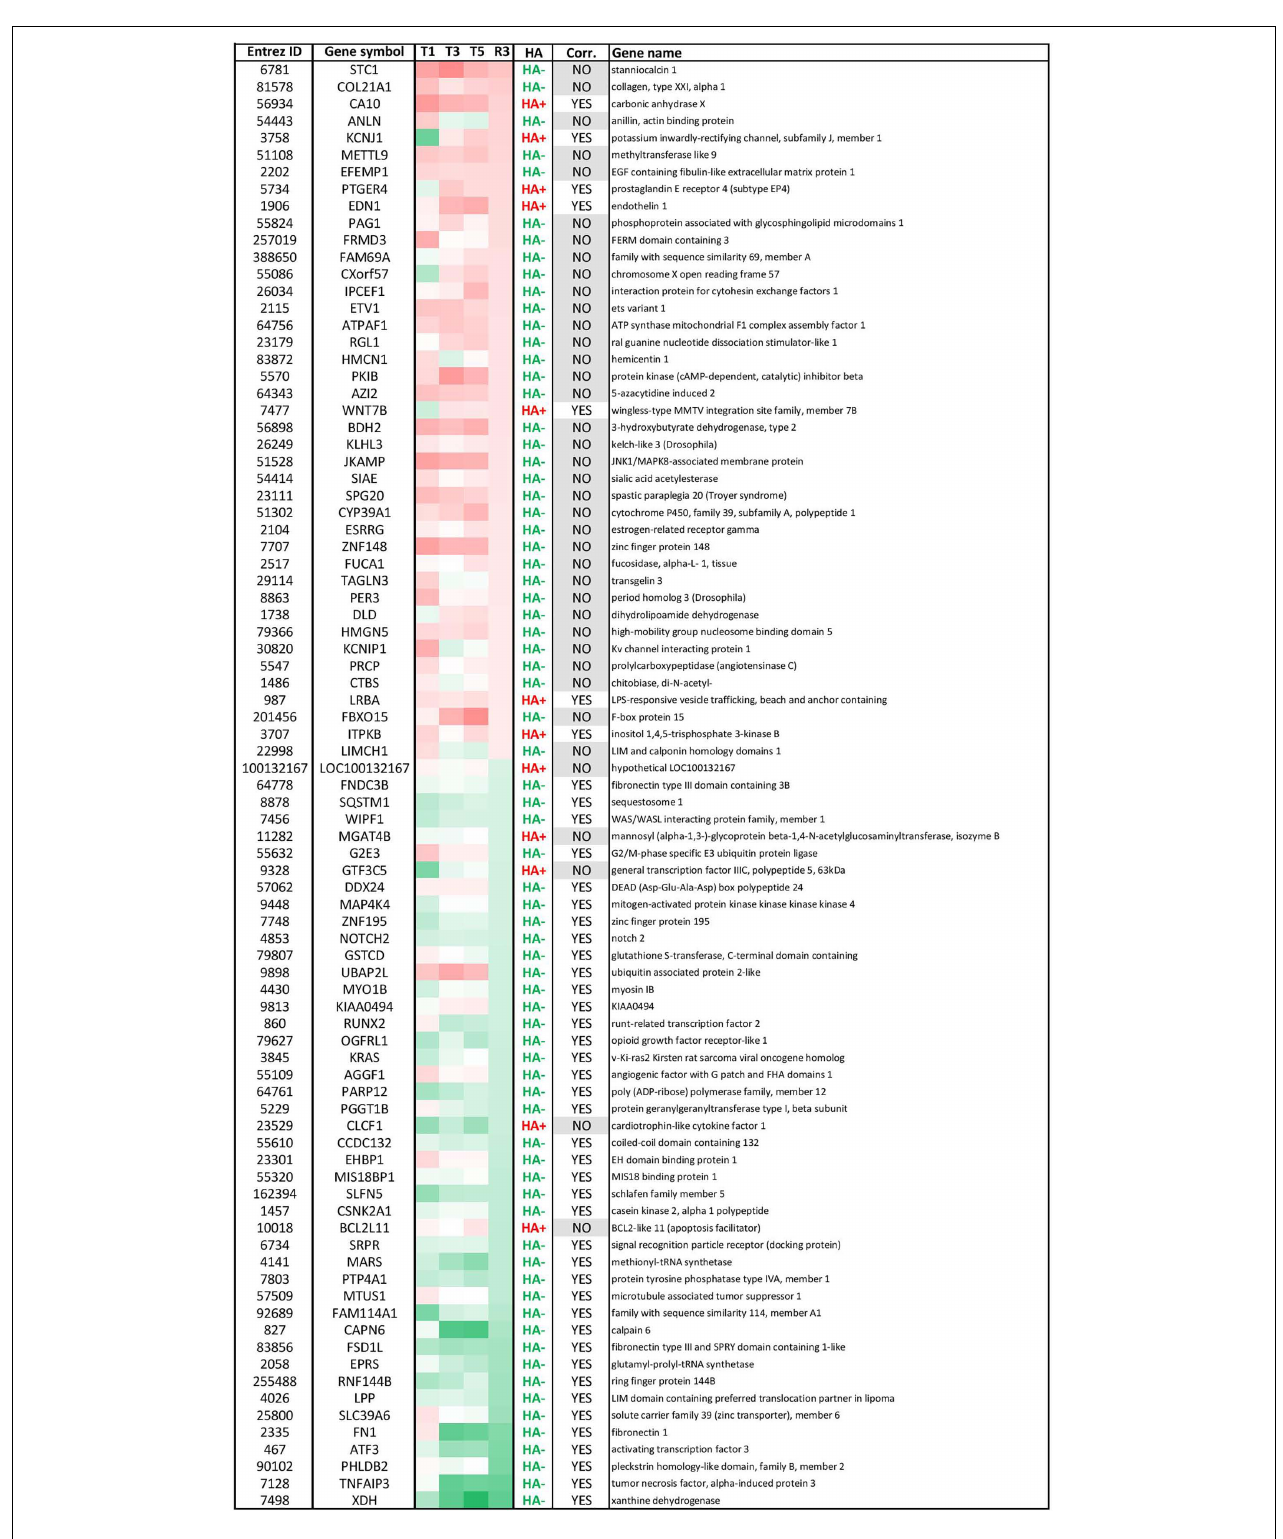
FIGURE 4 | Modulated genes with persistent histone acetylation (HA) modification after OTA washout. These 85 genes had (1) significantly altered mRNA levels at R3 ( ± 0.58 LFC) and (2) persistent HA modifications from T5 to R3. Within this list, 44 genes had HA modification consistent with the direction of GE (correlation: YES, i.e., up-regulated GE/HA+ or down-regulated GE/HA-) and 41 had inconsistent HA modifications (correlation: NO). Most genes had hypo-acetylated histones. Red corresponds to up-regulated GE. Green corresponds to down-regulated GE.